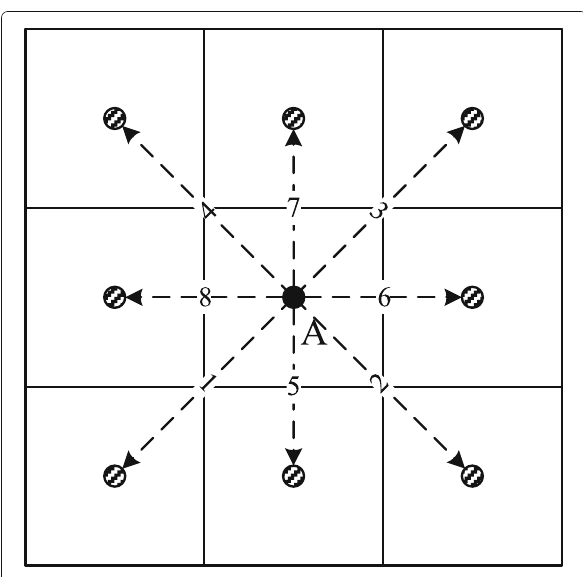
Fig. 6 The DN of current head node and corresponding transmission direction. Node A is the current head node, and the others are neighbor head